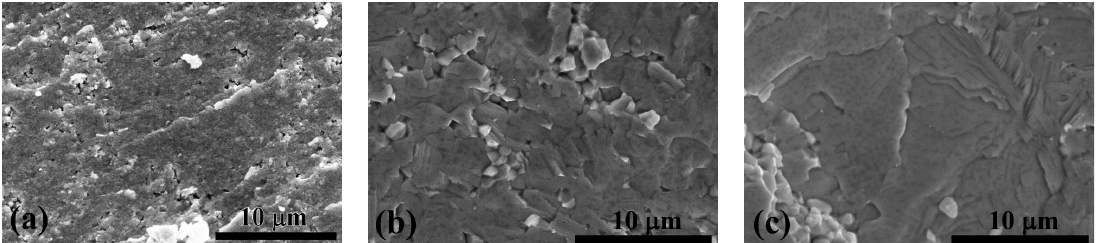
Figure 6. Fractured surfaces of extruded ZnSb with ER of ( a ) 1.56, and ( b ) 3.08, and ( c ) 6.9.